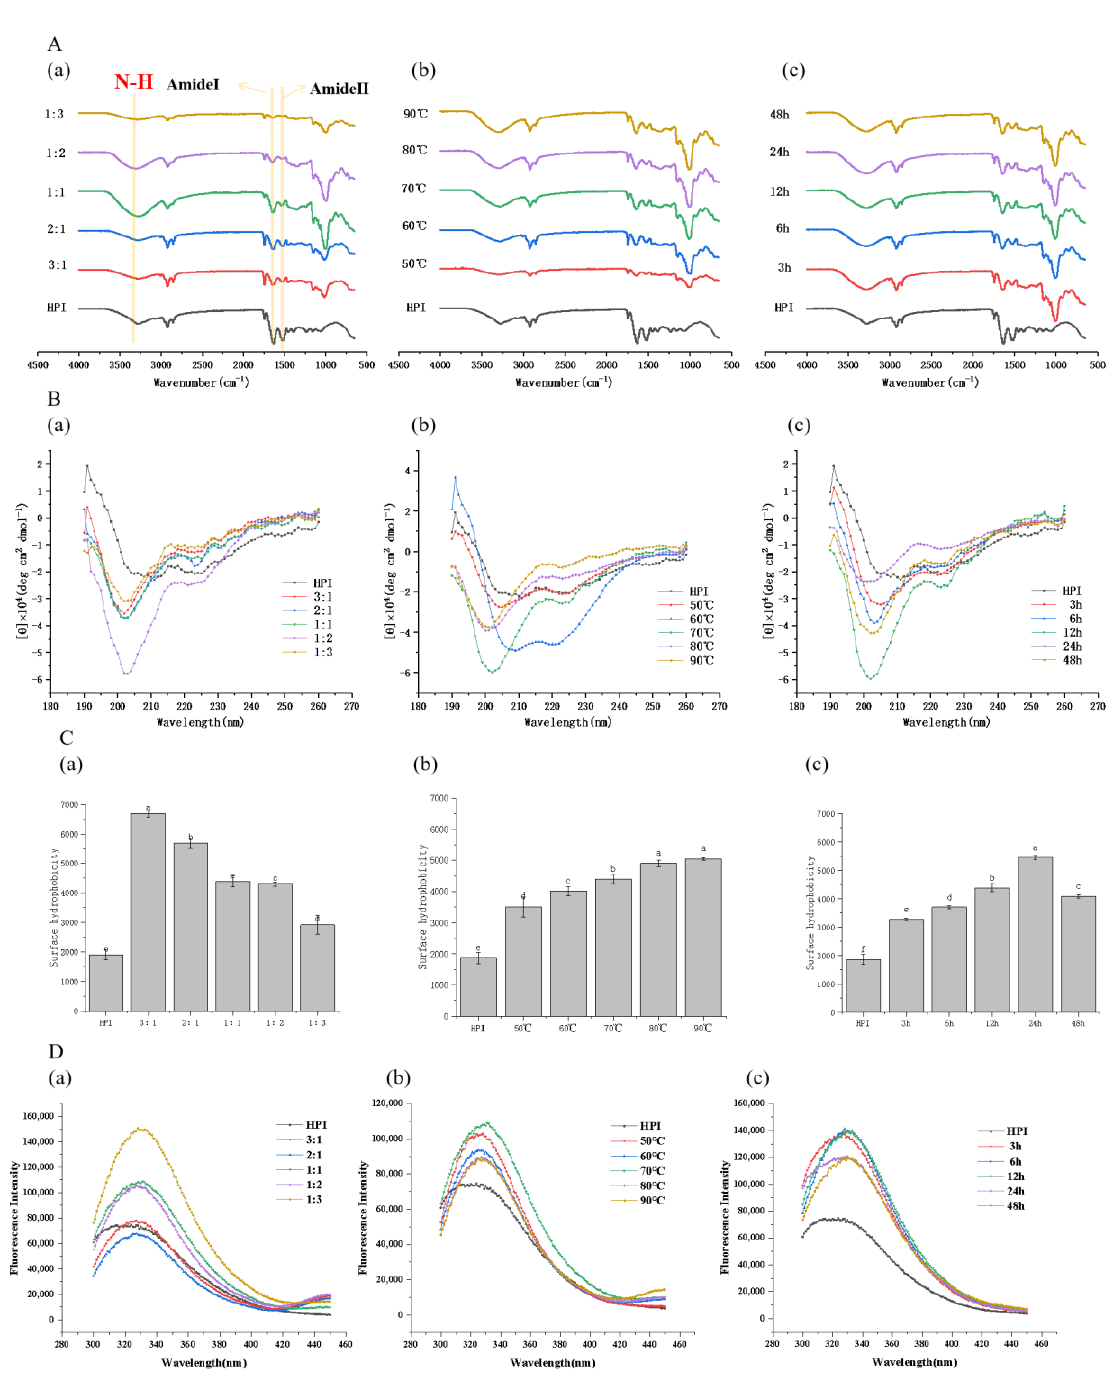
from 1:3 to 1:1, the N-H stretching vibration peak from 3282.11 cm − 1 to 3269.99 cm −